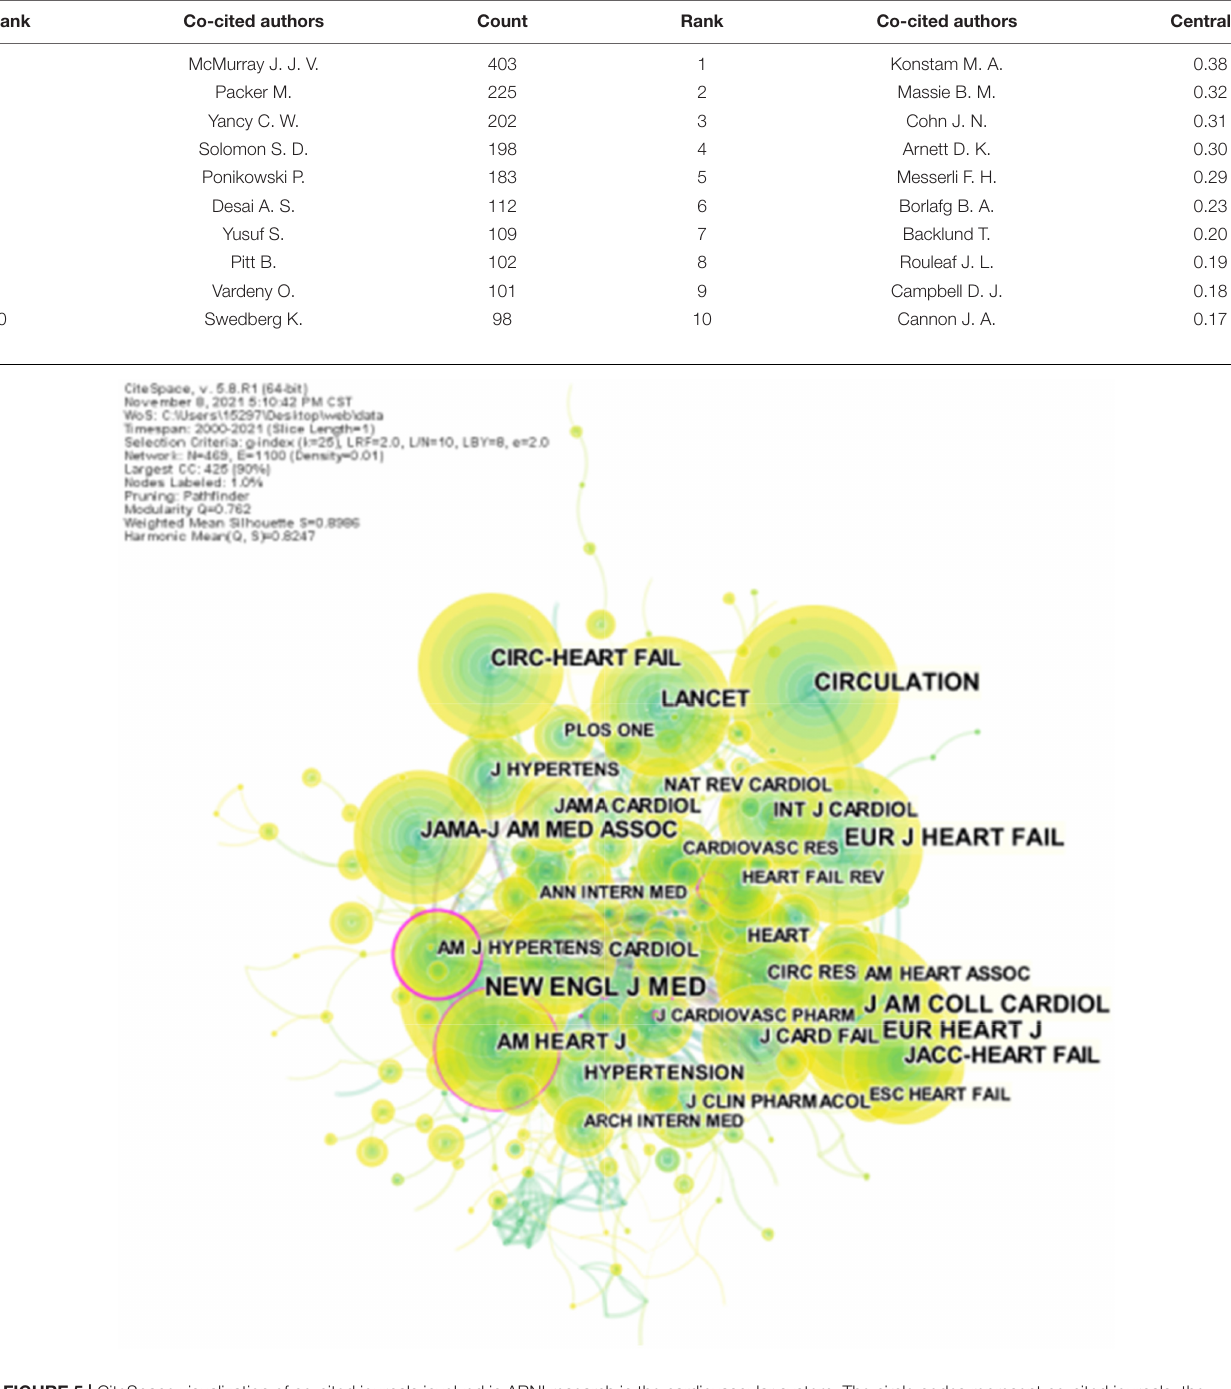
FIGURE 5 | CiteSpace visualization of co-cited journals involved in ARNI research in the cardiovascular system. The circle nodes represent co-cited journals; the links between nodes represent interdisciplinary interactions in the literature.